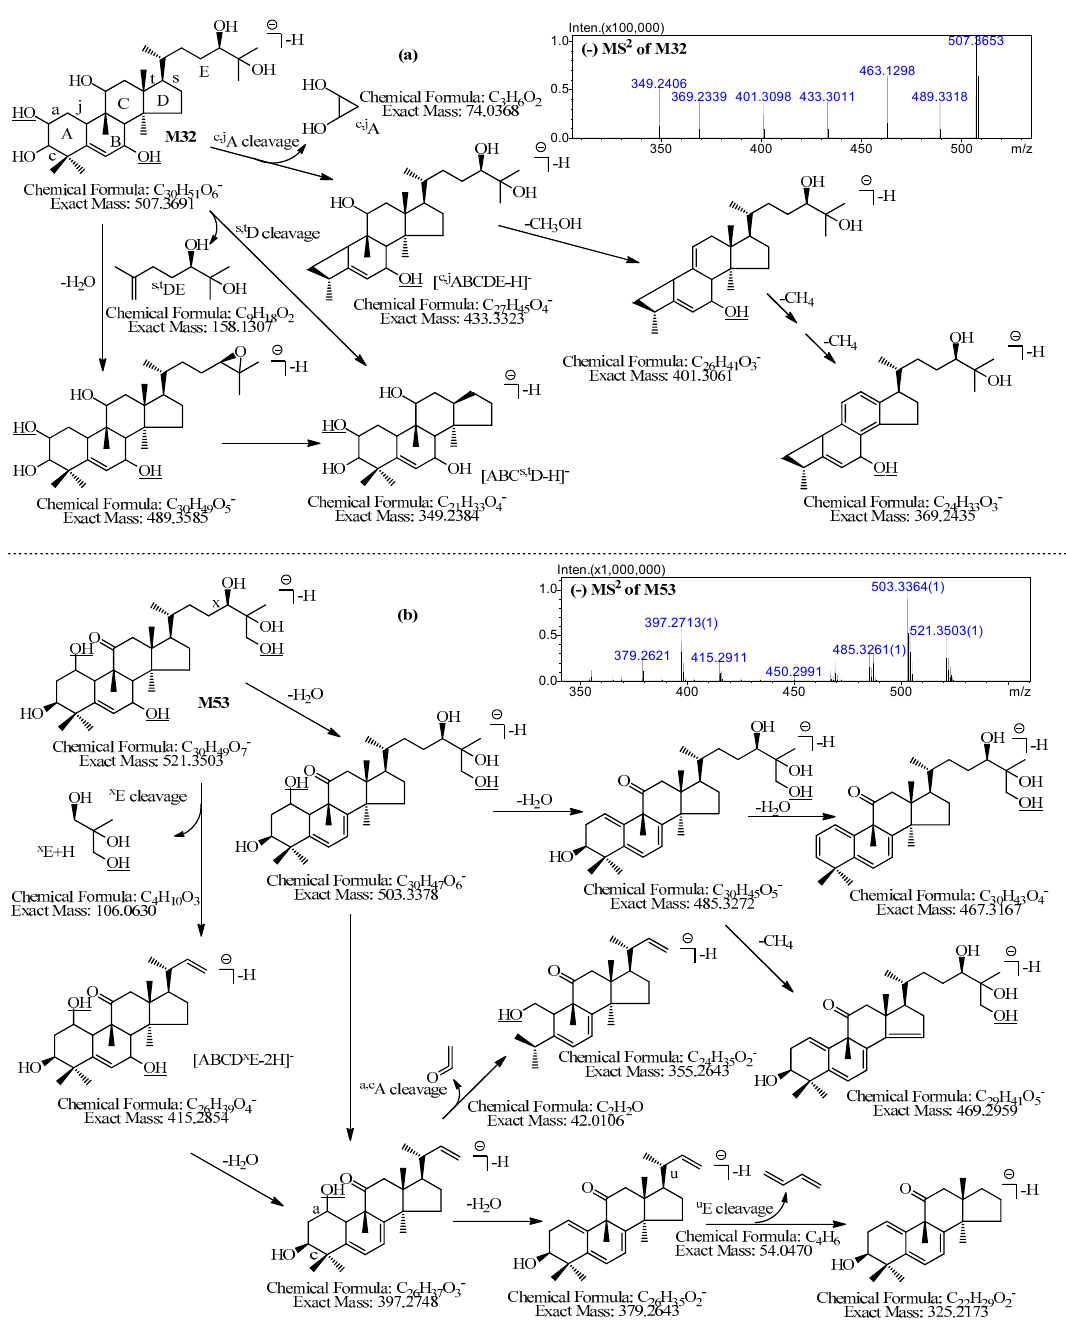
Figure 2. The MS 2 spectra, characteristic fragment ions, and proposed fragmentation pathways of M32 and M53 . ( a ) M32 ; ( b ) M53 .